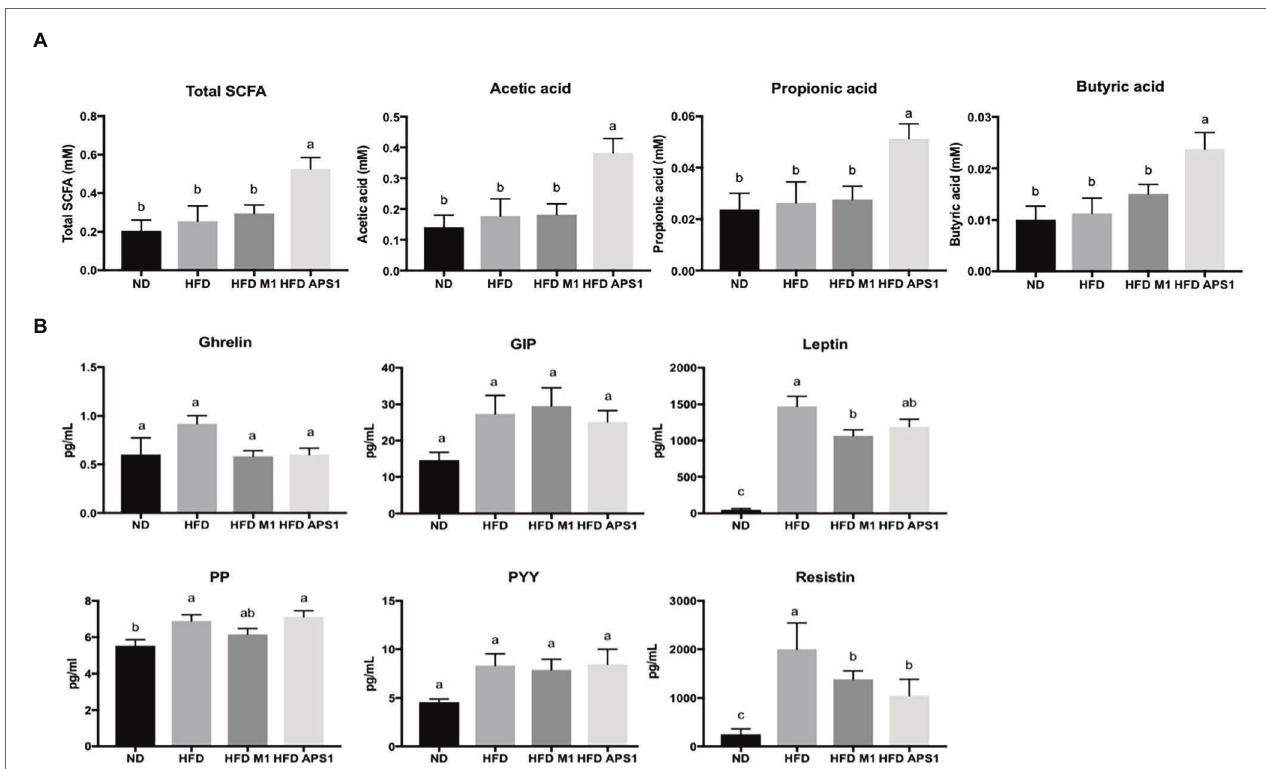
FIGURE 5 | Effects of M1 and APS1 interventions on (A) fecal short chain fatty acids (SCFAs) excretion and (B) expression of satiety hormones in HFD-induced obese mice. ( n = 8 per group). The data are expressed as the mean ± SEM. Labeled means without a common superscript letter differ, p <